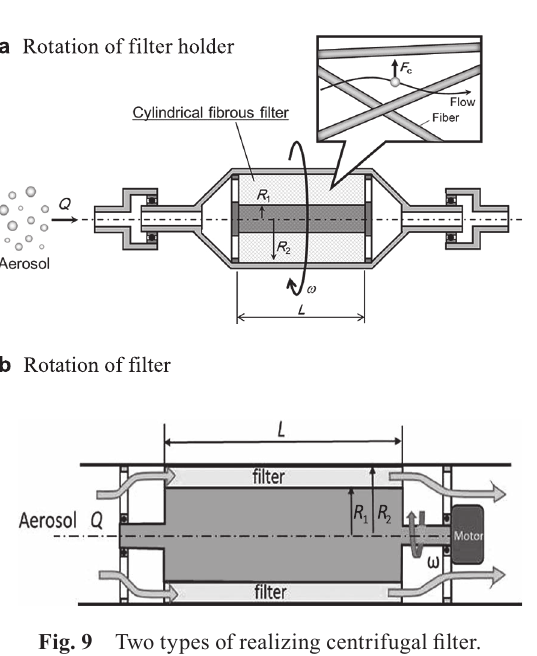
Fig. 9 Two types of realizing centrifugal